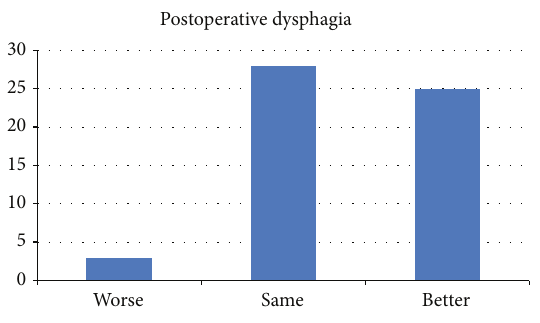
Figure 5: Postoperative